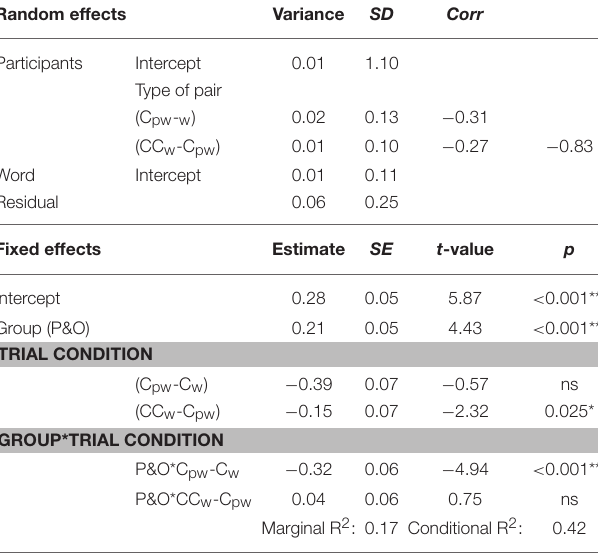
TABLE 2 | Results of mixed-model analysis of the effects of group (Phonology, Phonology & Orthography) and type of pair (CC pw -C w , C pw -C w , CC w -C pw ) on consonant duration